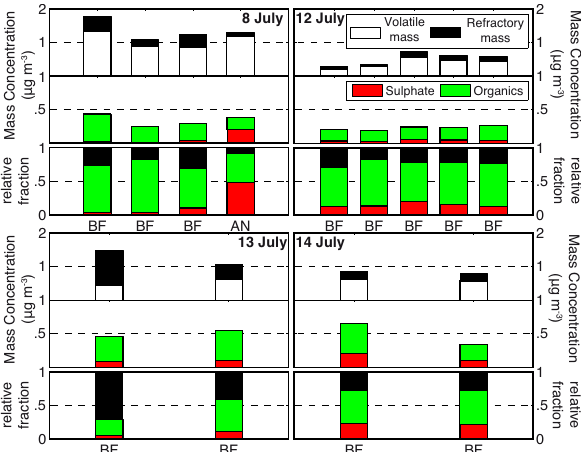
Fig. 7. Log-normal fitted aerosol number size distributions (solid line) and measurements (solid line with symbol) for the selected time windows of the 4 respective